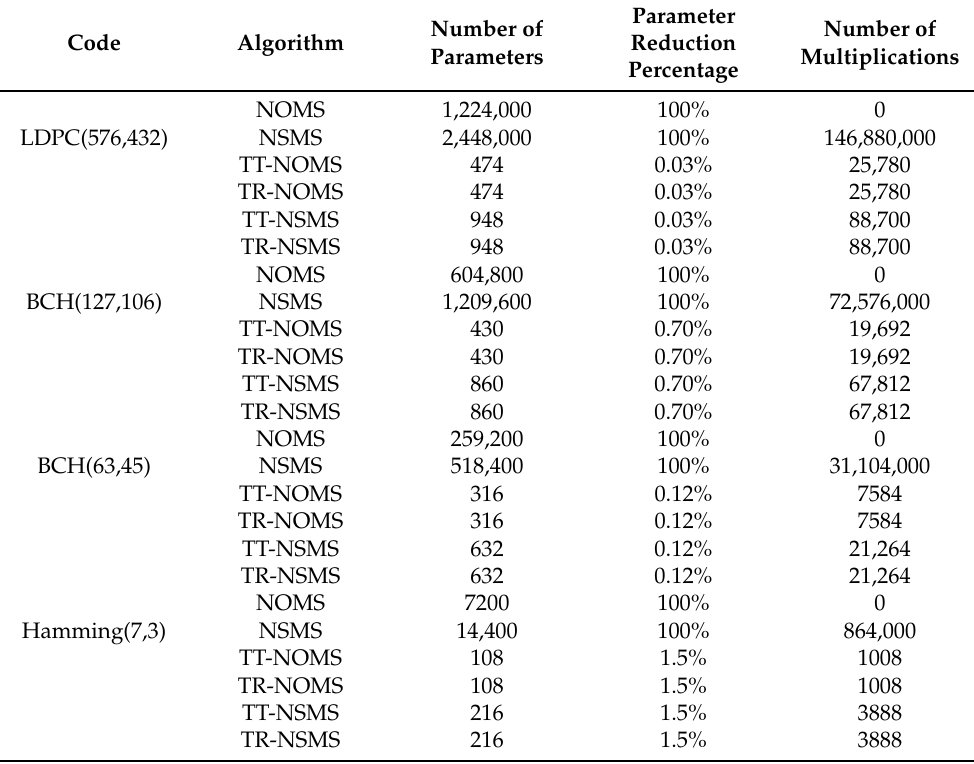
Figure 3. BER performance of TT-NOMS, TT-NSMS, NOMS [22] and NSMS algorithms for Ham- ming(7,3) code. Table 2. Comparison of parameters and multiplication in NOMS [22], NSMS, TR-NOMS and TR- NSMS